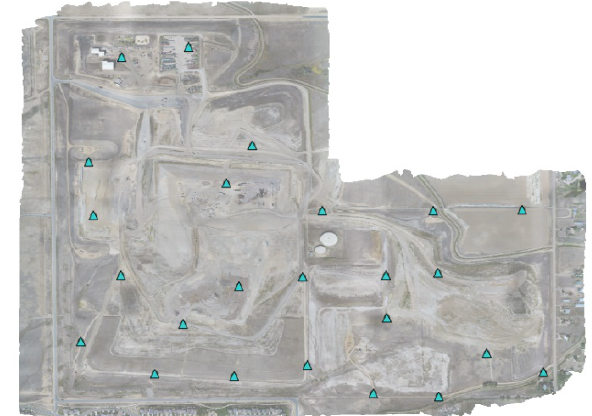
Figure 1. Illustration of the full GCP distribution in the study area as indicated by the blue green shaded